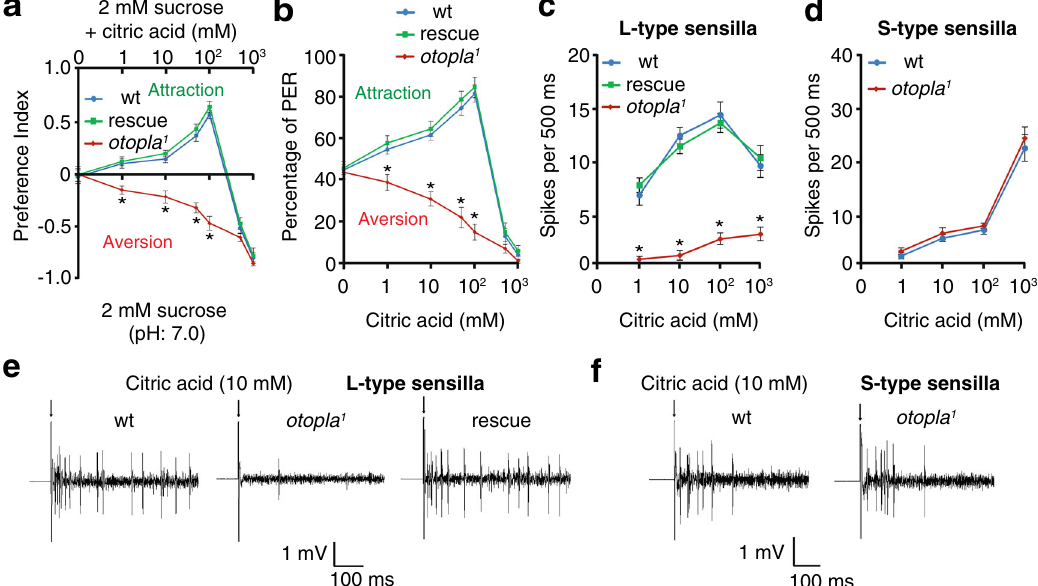
Fig. 3 Feeding and electrophysiological responses to low and high concentrations of citric acid for wild-type (wt), otopla 1 mutant, and rescue fl ies. a Feeding preference between neutral foods (2 mM sucrose) and foods comprising 2 mM sucrose and varying concentrations of citric acid (1 mM, pH 3.7; 10 mM, pH 3.3; 100 mM, pH 2.8; 1000 mM, pH 2.0). Data are presented as mean ± SEM. n = 10 trials, * p = 0.0001 (1 mM) and * p < 0.0001 (10, 50, and 100 mM), one-way ANOVA tests. b Proboscis extension re fl ex (PER) responses to foods containing 30 mM sucrose and a series of concentrations of citric acid. Data are presented as mean ± SEM. n = 10 trials, * p = 0.0007 (1 mM) and * p < 0.0001 (10, 50, and 100 mM), one-way ANOVA tests. c , d Statistical analyses of spike frequencies evoked by different concentrations of citric acid at the L6 sensilla ( c ; n = 10 animals, * p < 0.0001 (1 – 1000 mM), one-way ANOVA tests) and S5 sensilla ( d ; n = 10 animals). Data are presented as mean ± SEM. e , f Representative spike trains elicited by 10 mM citric acid at the L6 sensilla ( e ) and S5 sensilla ( f ). Arrows indicate the onset of taste stimuli.